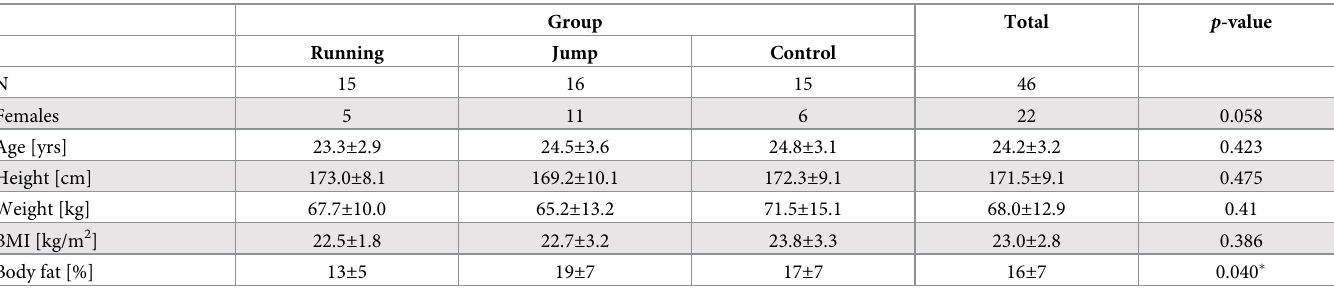
Table 1. Group characteristics at baseline.